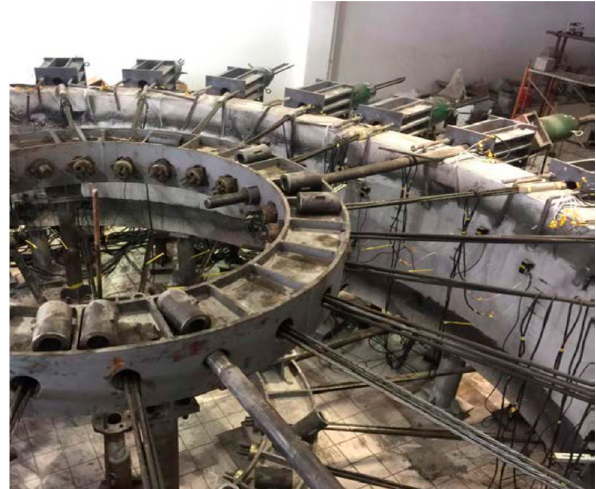
Figure 7. Loading system.